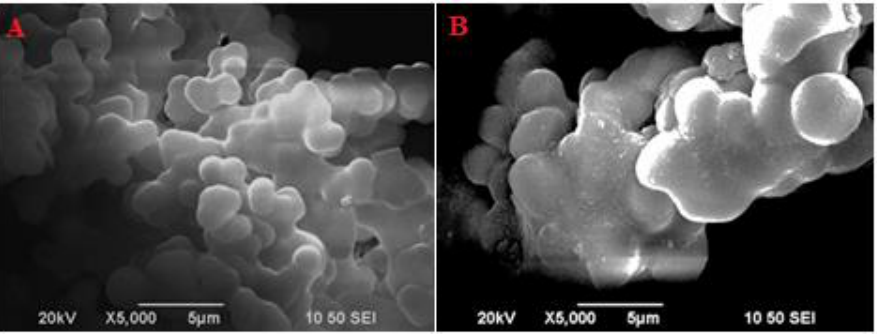
Figure 6. SEM images for fresh catalyst ( A ) and recycled catalyst after four runs ( B ).